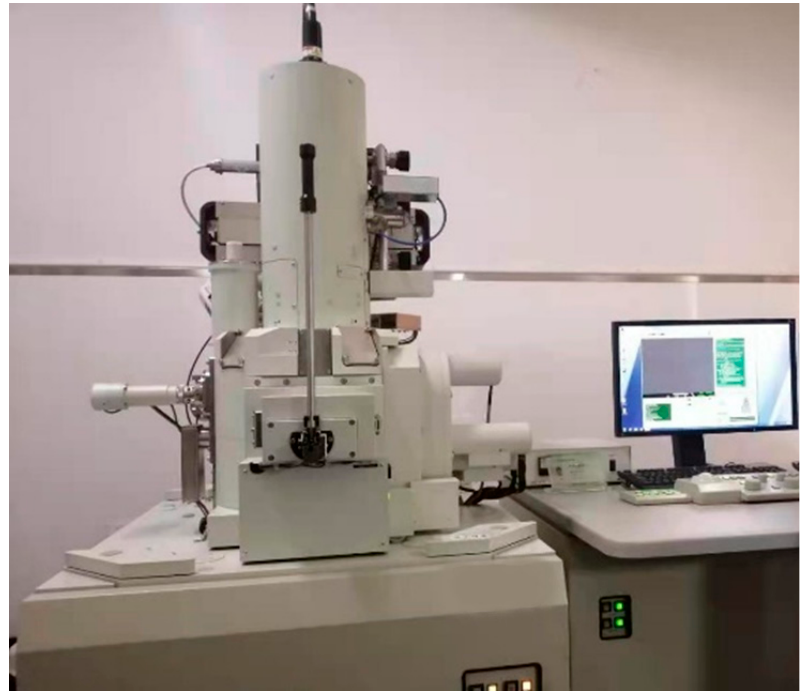
Figure 4. SEM device.